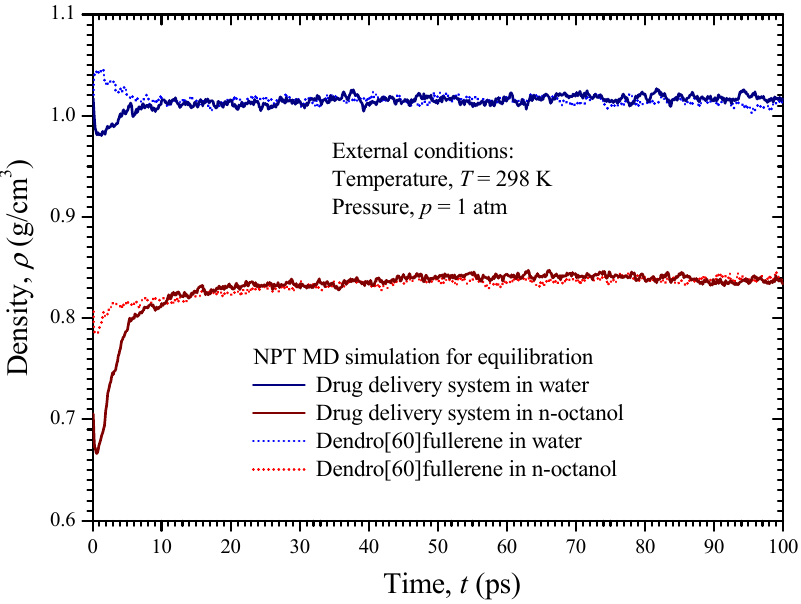
Figure 9. The density of the four investigated unit cells versus time during the NPT MD analysis. To compute the Gibbs free energies at room temperature through Equation (5), a series of simulations for the four unit cells of Figure 7c,d and Figure 8c,d is performed by increasing the coupling coefficient λ from 0 to 1 using a stable increment of ∆ λ = 0.05. Note that for each new increment of the coupling coefficient, a full independent MD analysis is performed for 100 ps under the NVT ensemble, to achieve the required equilibration of the system under consideration. A time step of 1 fs is adopted for all simulations. At the end of each NVT analysis, an optimization process is carried out to further minimize, if possible, the potential energy of the system. The simulations for each unit cell are associated with the separate computation of the ideal energy, van der Waals, and electrostatic